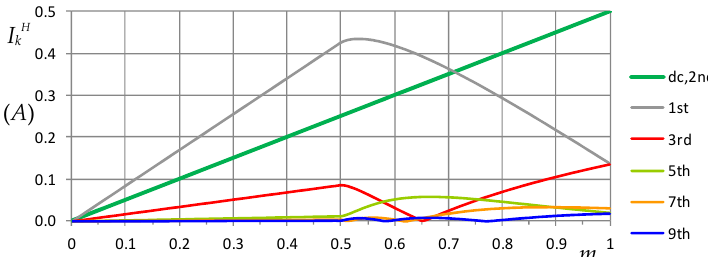
Figure 6. Amplitudes of low-order H-bridge input current harmonics for sinusoidal unity output current as a function of the modulation index.